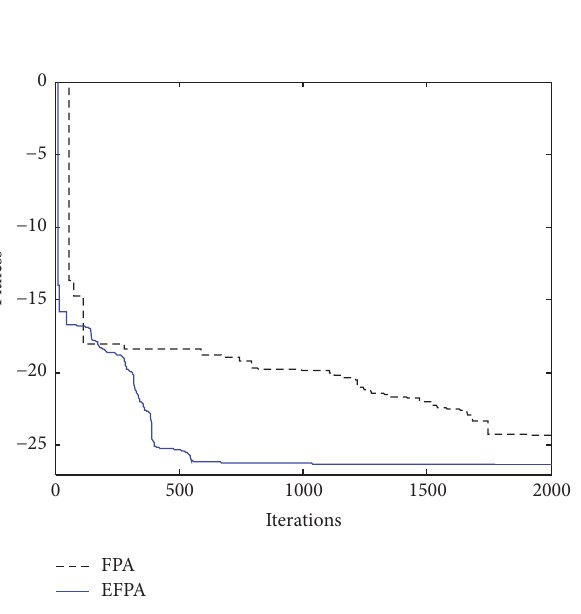
Figure 4: Convergence plots of 22-element LAA. Figure 5: Radiation plot of 22-element EFPA optimized